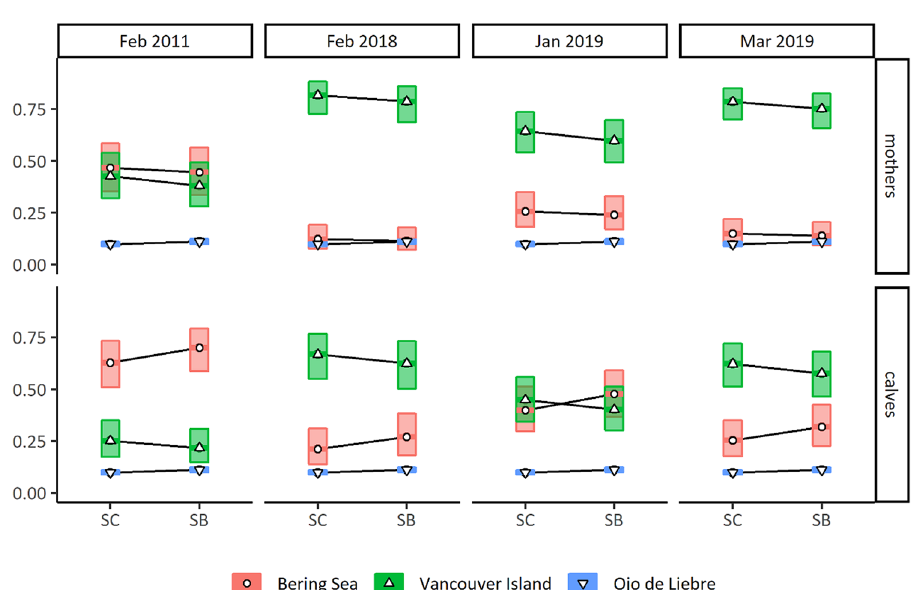
Figure 5. Top-selected general linear mixed effect model for all sources contribution patterns to the isotopic mixture of mothers’ epidermis, placental blood (i.e., calves SC) and maternal milk (i.e., calves SB). Boxes indicate the upper and lower confidence levels of the estimated marginal